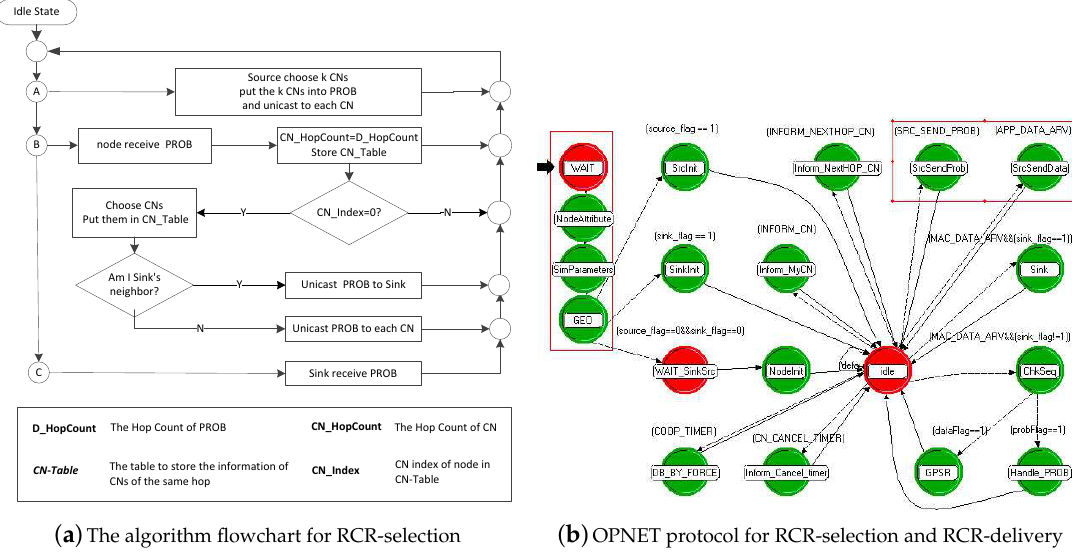
Figure 5. The algorithm flowchart and OPNET protocol for the RCR scheme.